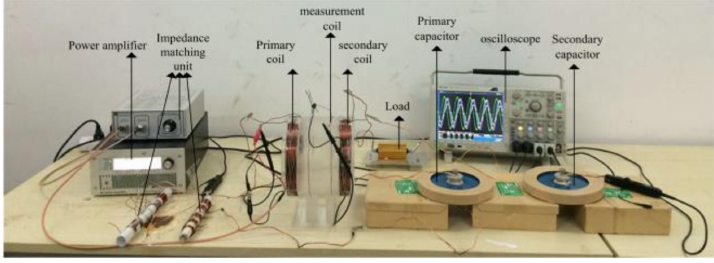
Figure 12. Experimental